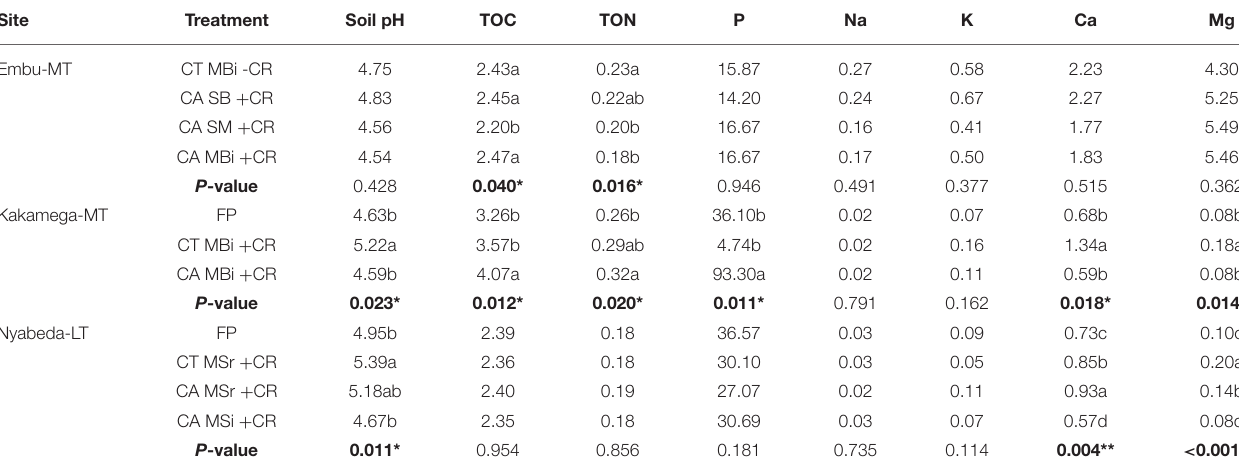
TABLE 6 | Soil chemical characteristics (0–30cm soil depth) across treatments of Embu, Nyabeda, and Kakamega.